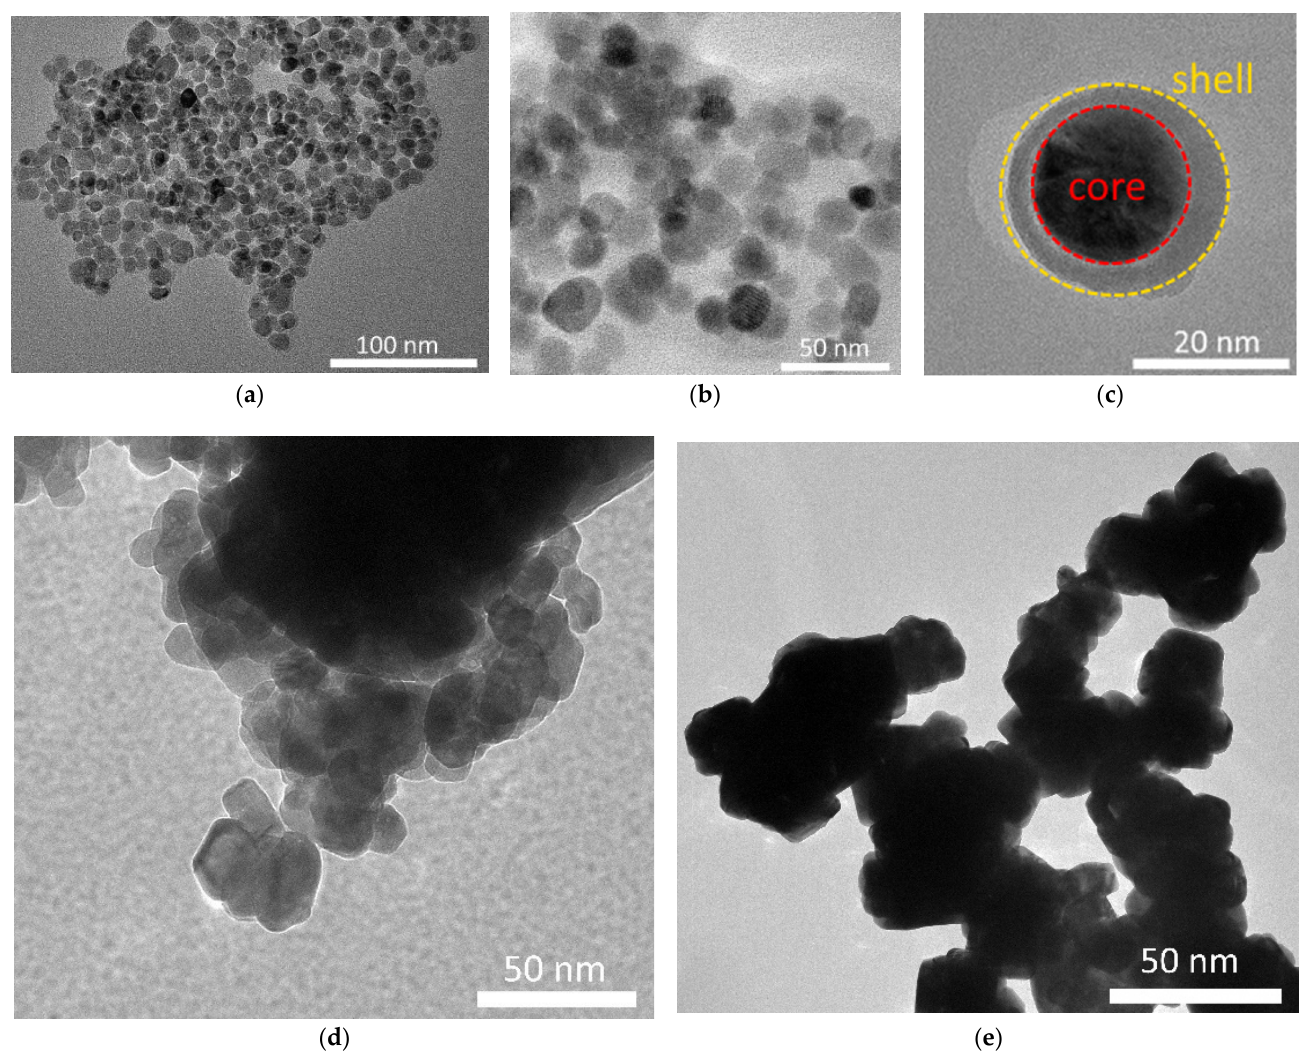
Figure 2. TEM images of the studied nanostructures: ( a ) S0; ( b ) S1; ( c ) S2; ( d ) S3; ( e ) S4.